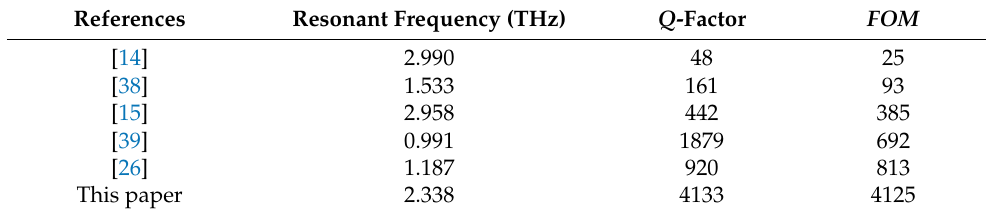
Figure 7. ( a ) Absorption spectra of the absorber in different environment refractive indexes n . ( b ) Function relationship of resonance wavelength in different environment refractive indexes n . Table 1. Comparisons of Q -factor and FOM among designs in previous